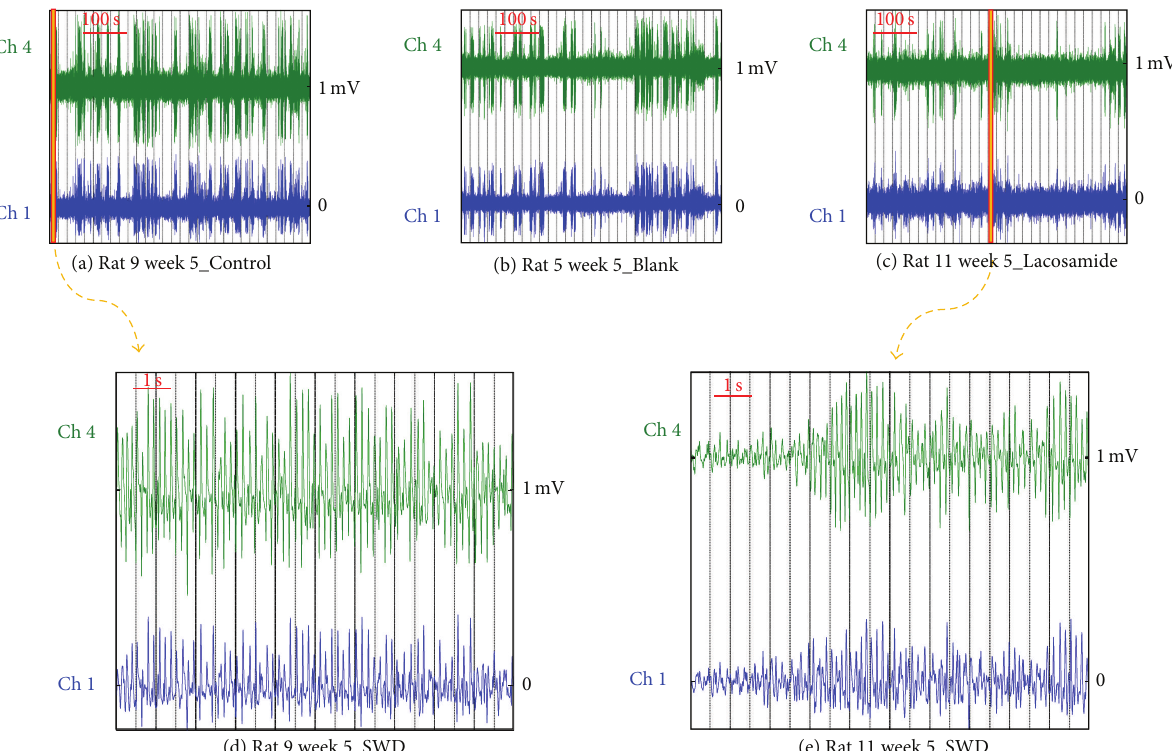
Figure 5: Example of EEG recording from 3 rats belonging to group control (a), blank polymer (b), and lacosamide polymer (c). Figures (d) and (e) are amplifications of spike-and-wave discharges observed during the recording shown and Figures (a) and (c),